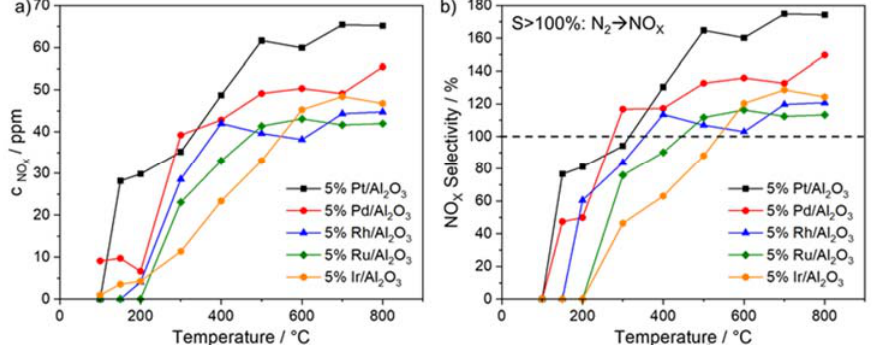
Figure 3. ( a ) NO X concentration and ( b ) NO X selectivities vs. reaction temperature for different noble metal catalysts, WHSV = 600 L/g h.